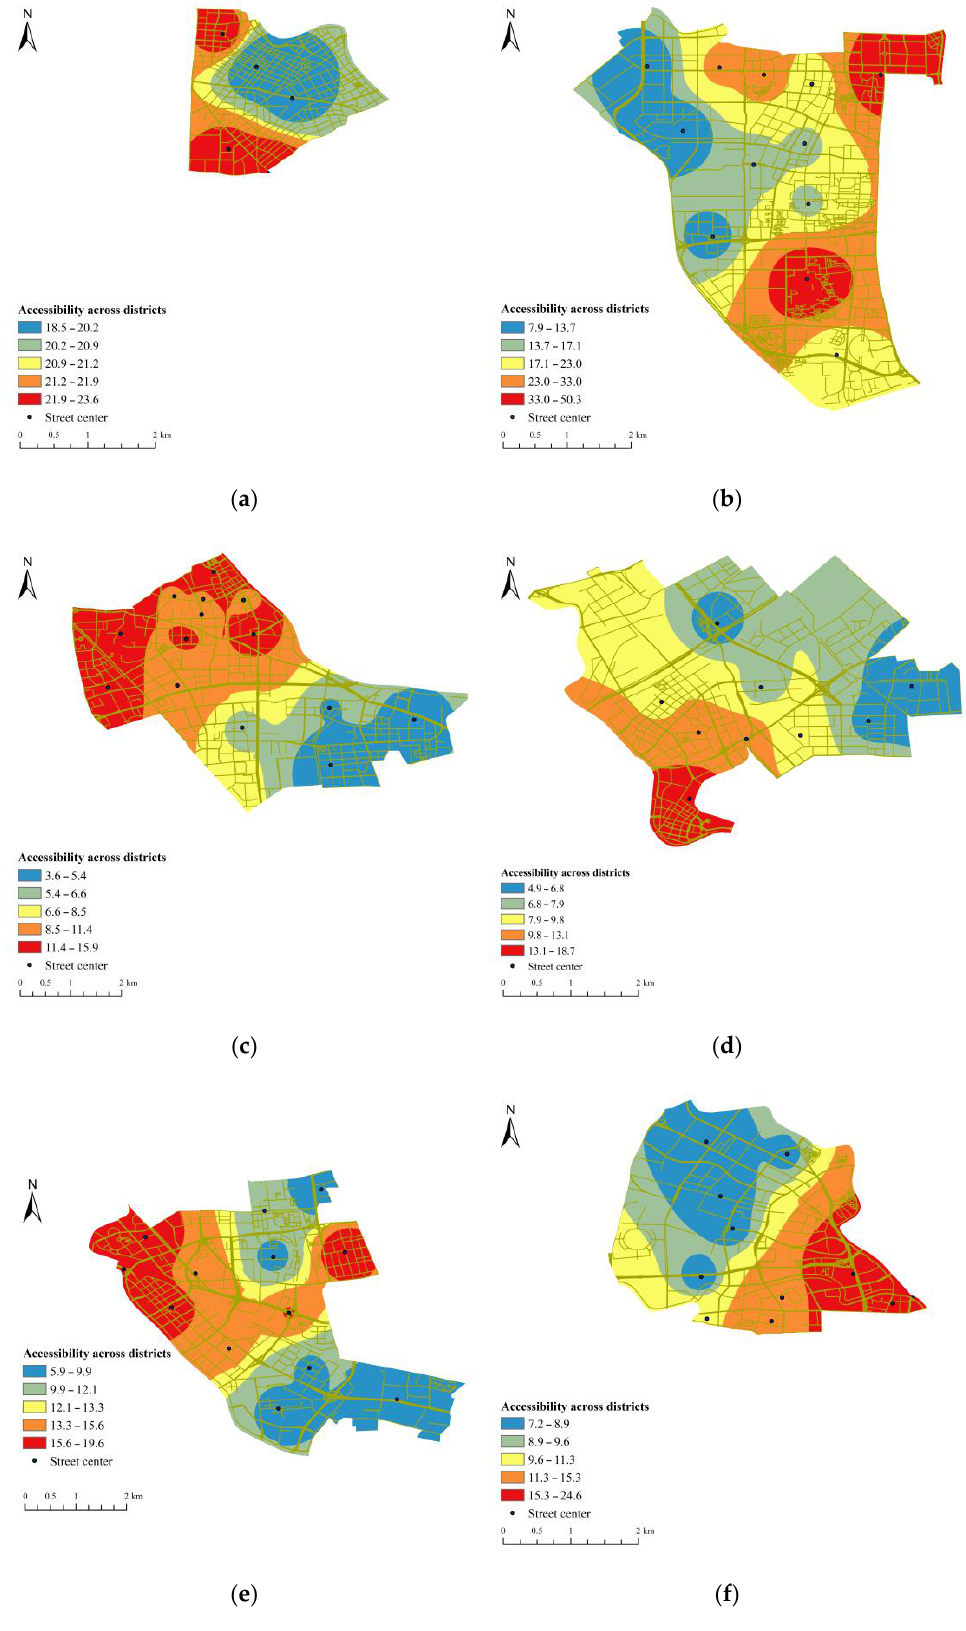
Figure 3. Example of accessibility to tertiary hospitals across regions of Tianjin. ( a ) Heping